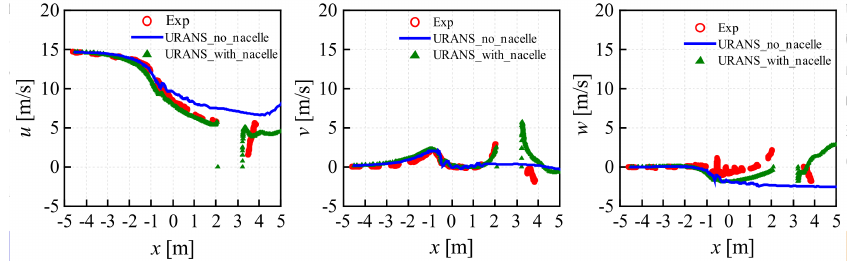
Figure 11. Comparisons of axial velocity distributions regarding nacelle